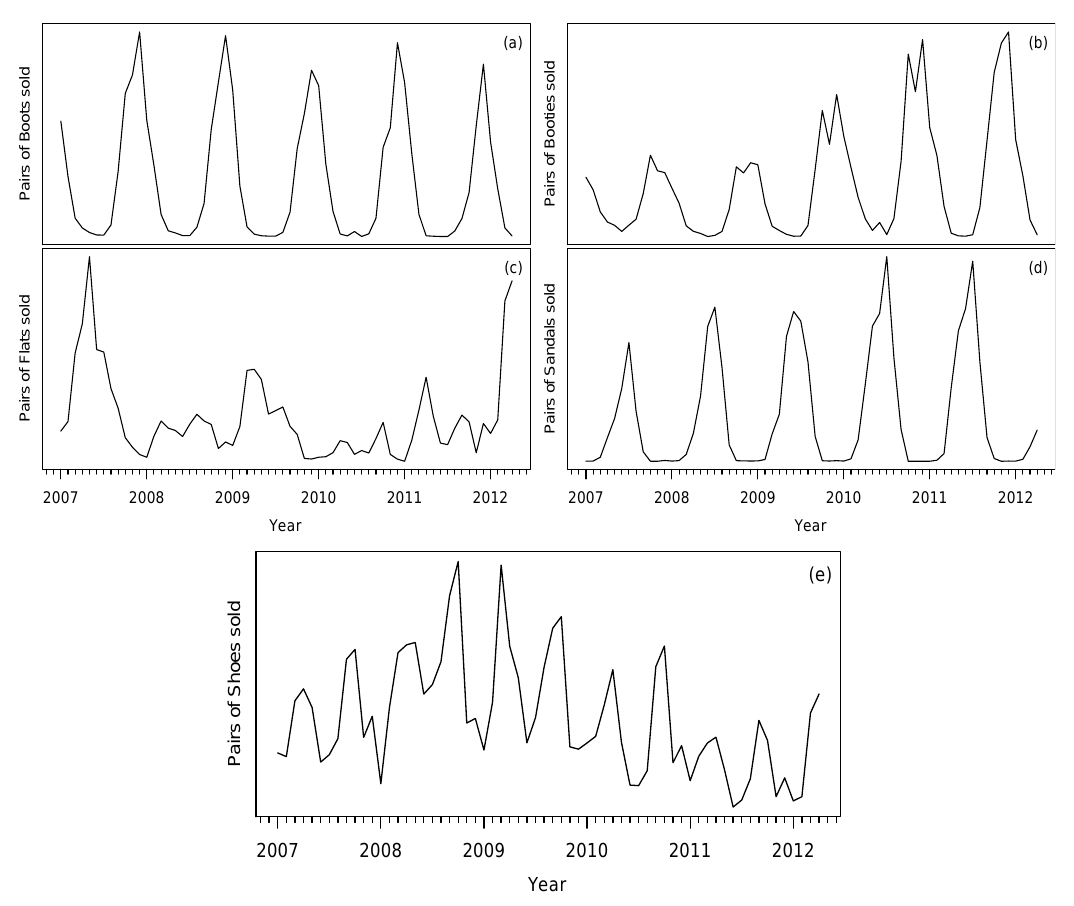
Figure 1. Monthly sales of the five footwear categories between January 2007 and April 2012: ( a ) pairs of Boots; ( b ) pairs of Booties; ( c ) pairs of Flats; ( d ) pairs of Sandals; and ( e ) pairs of